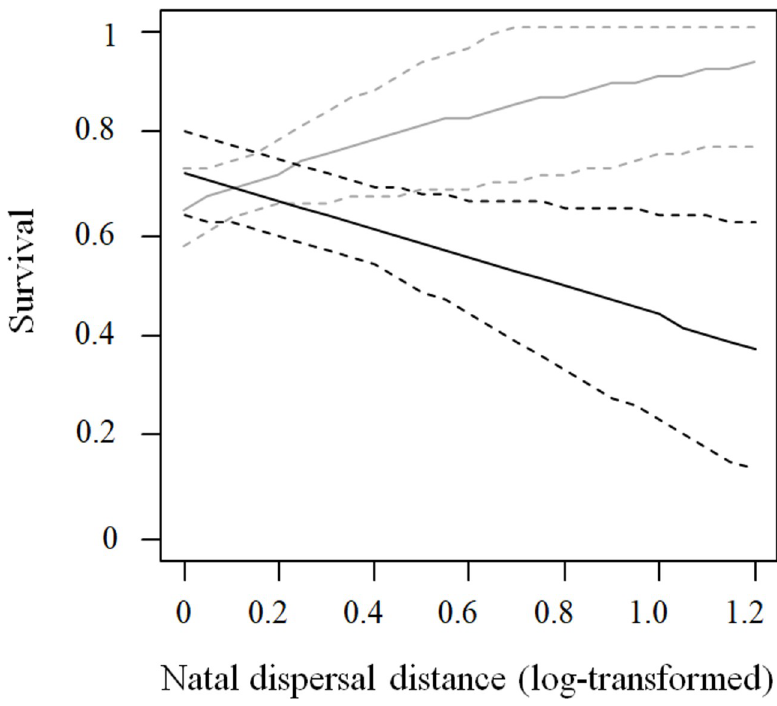
Fig 2. Relationship between natal dispersal and survival probabilities of male (gray lines) and female (black lines) burrowing owls Athene cunicularia . Solid lines represent the general tendency obtained using the first model shown in Table 5; dashed lines: 95% confidence